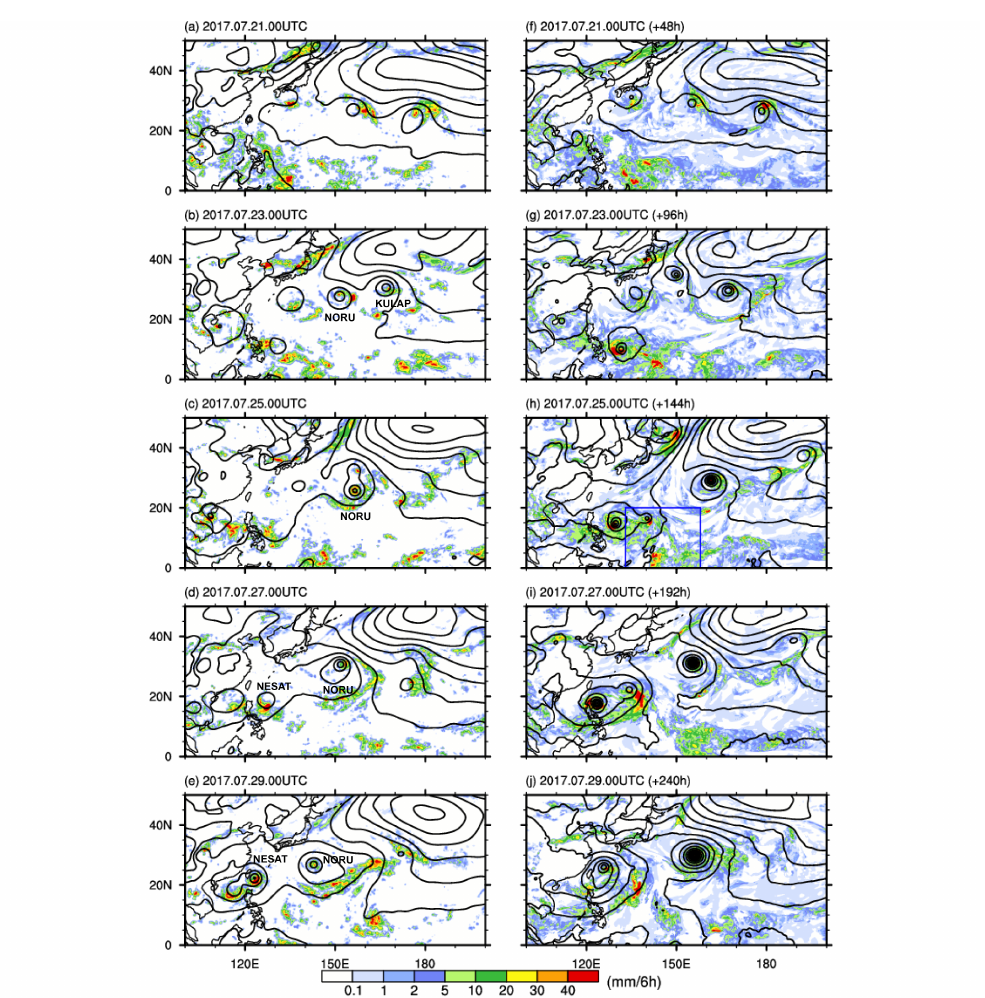
Figure 1. Fields of the six-hourly precipitation rate at 0000 UTC on July ( a ) 21, ( b ) 23, ( c ) 25, ( d ) 27, and ( e ) 29, 2017 from the TMPA observations and the same fields from the CTL experiment ( f – j ). Sea-level pressure contours (4 hPa interval) from the ERA5 reanalysis data and CTL experiment are added to show synoptic systems with the precipitation rate fields. The area shown in Figure 2a is indicated with a rectangle with blue solid lines in ( h